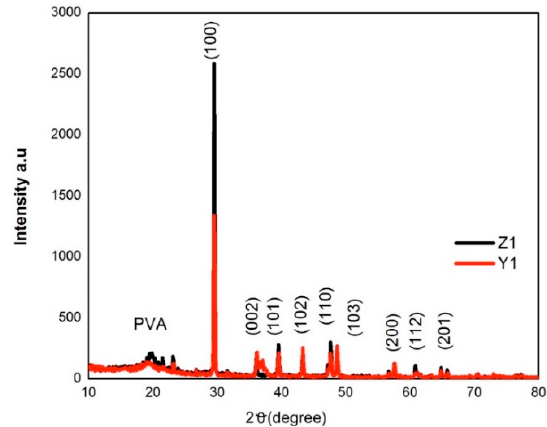
Figure 10. XRD pattern of PVA/ZnO Nps membranes.